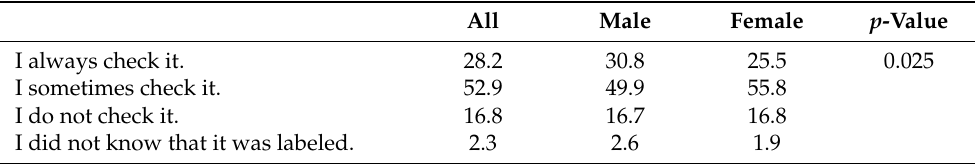
Table 11. Confirmation of labeling of vitamin contents on fortified food/supplements.